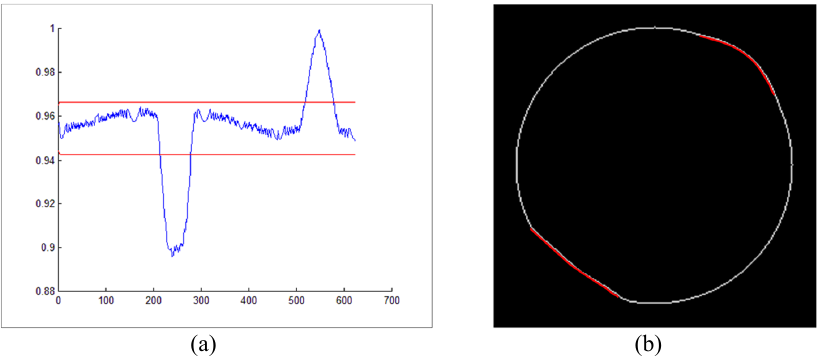
Fig. 5. The detection result of the 7-th circle of the concentric circles pattern in the sample image processed by the EWMA method: (a) the EWMA control chart; (b) the regions of detected distortion flaws marked in